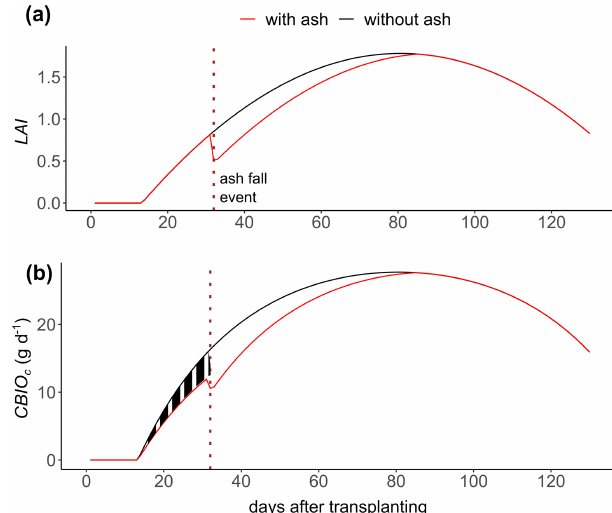
Figure 5. Temporal evolution of leaf area index (LAI) (a) and daily biomass accumulation (CBIO c ) (b) of a tomato plant exposed to ∼ 570gm − 2 of ash (size range: 90–125µm) 32d after transplant- ing (i.e. at 25% of the growth period) in dry leaf surface conditions. The hatched area represents the leaf biomass produced by the plant before the ashfall event and which will undergo premature senes- cence after it. The ash-covered leaf biomass is inferred from the leaf-to-canopy biomass ratio (i.e. 60%) and the percentage of leaf biomass covered with ash (i.e. 48% for tomato plants in dry leaf surface conditions, Table